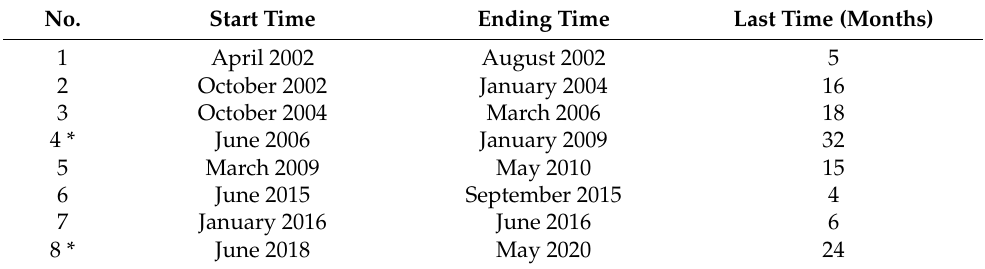
Table 3. Onset, termination and duration of droughts from April 2002 to May